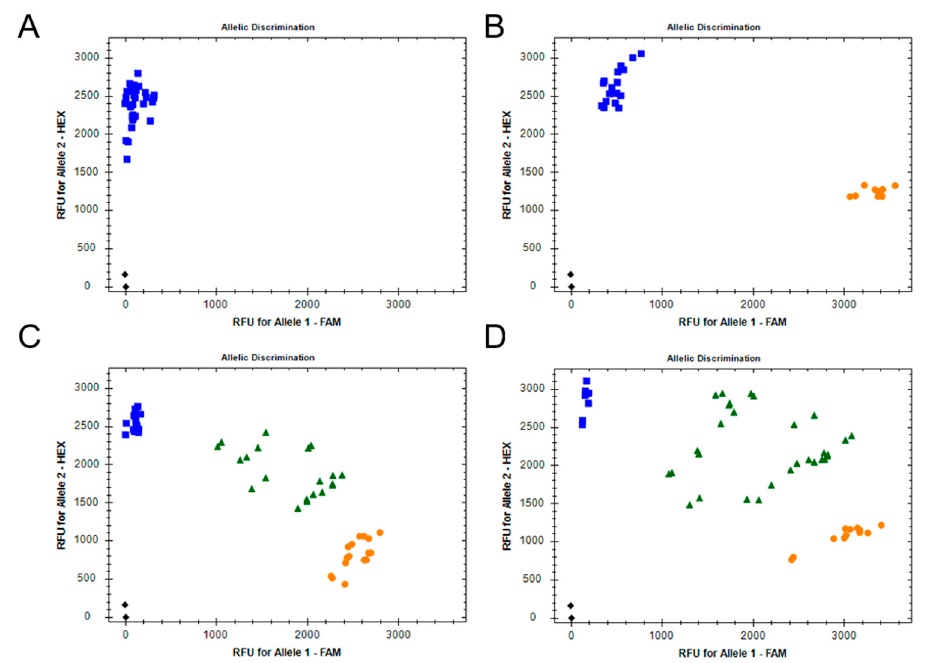
Figure 3. Bivariate plot showing the discrimination of di ff erent acetylcholinesterase alleles in Spodoptera frugiperda samples by an allele-specific real-time PCR fluorescent probe assay. Each dot represents a single larva. Blue squares represent mutant RR homozygotes (V290; allele 1), orange circles susceptible SS homozygotes (F290; allele 2) and green triangles SR heterozygotes (F290 / V290). Analysis of fall armyworm field samples collected in ( A ) Puerto Rico, ( B ) Brazil, ( C ) Kenya and ( D ) Indonesia.